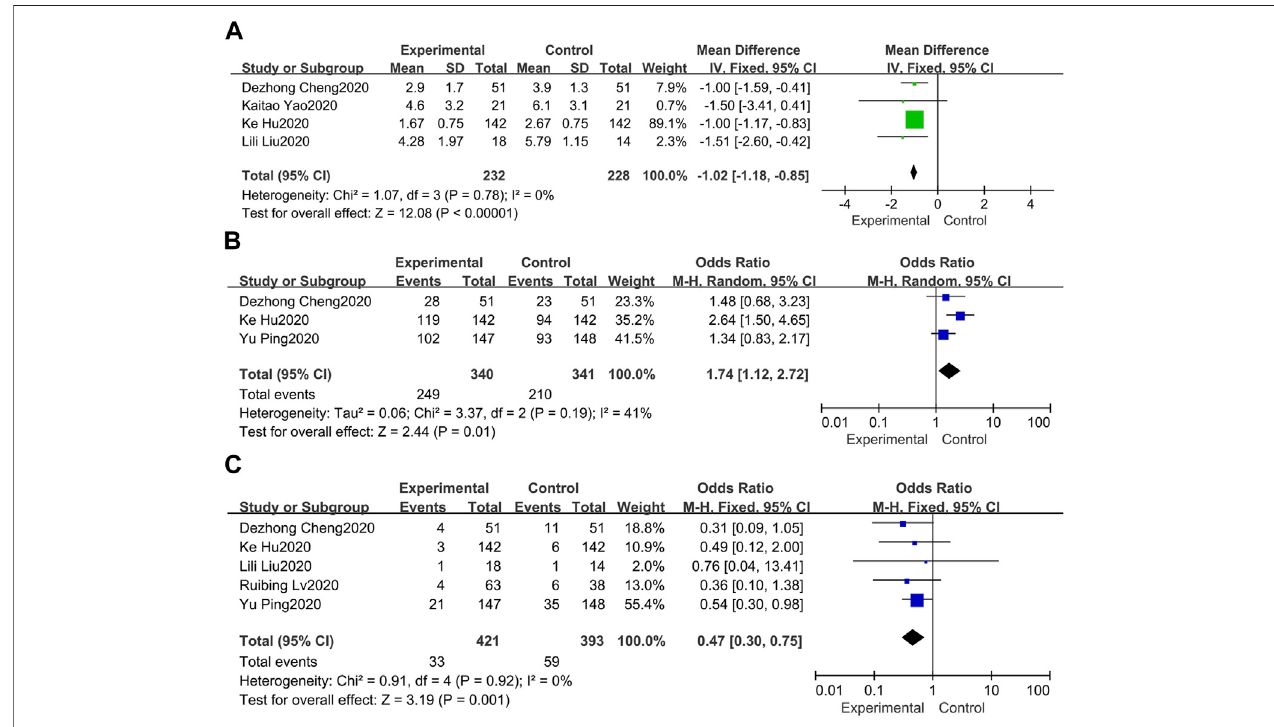
FIGURE4| Forestplotsofthepooledresultsofthemeta-analysisforthefeverduration (A) ,chestCTmanifestations (B) ,andrateofconversiontoseverecases (C) .